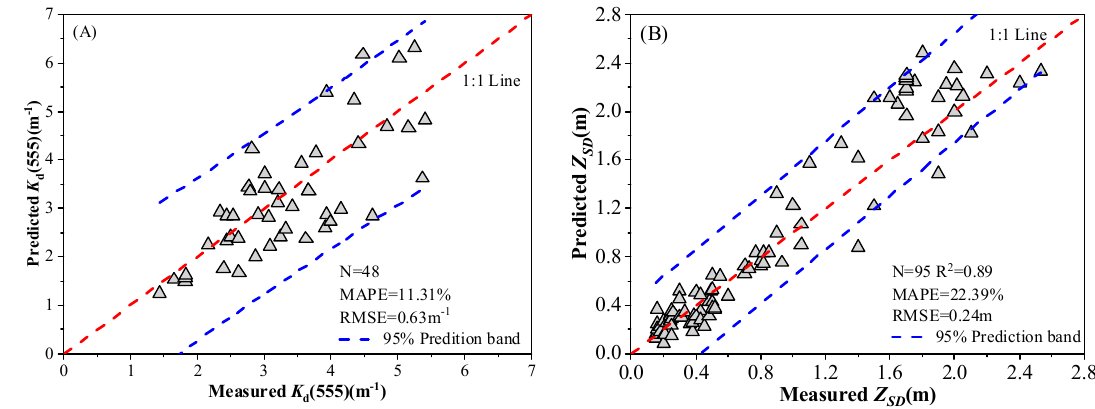
Figure 4. Validation of the K d ( 555 ) ( A ) and Z SD ( B ) between the measured and predicted values. Applicability verification of the new algorithm in Lake Dongting ( C ).